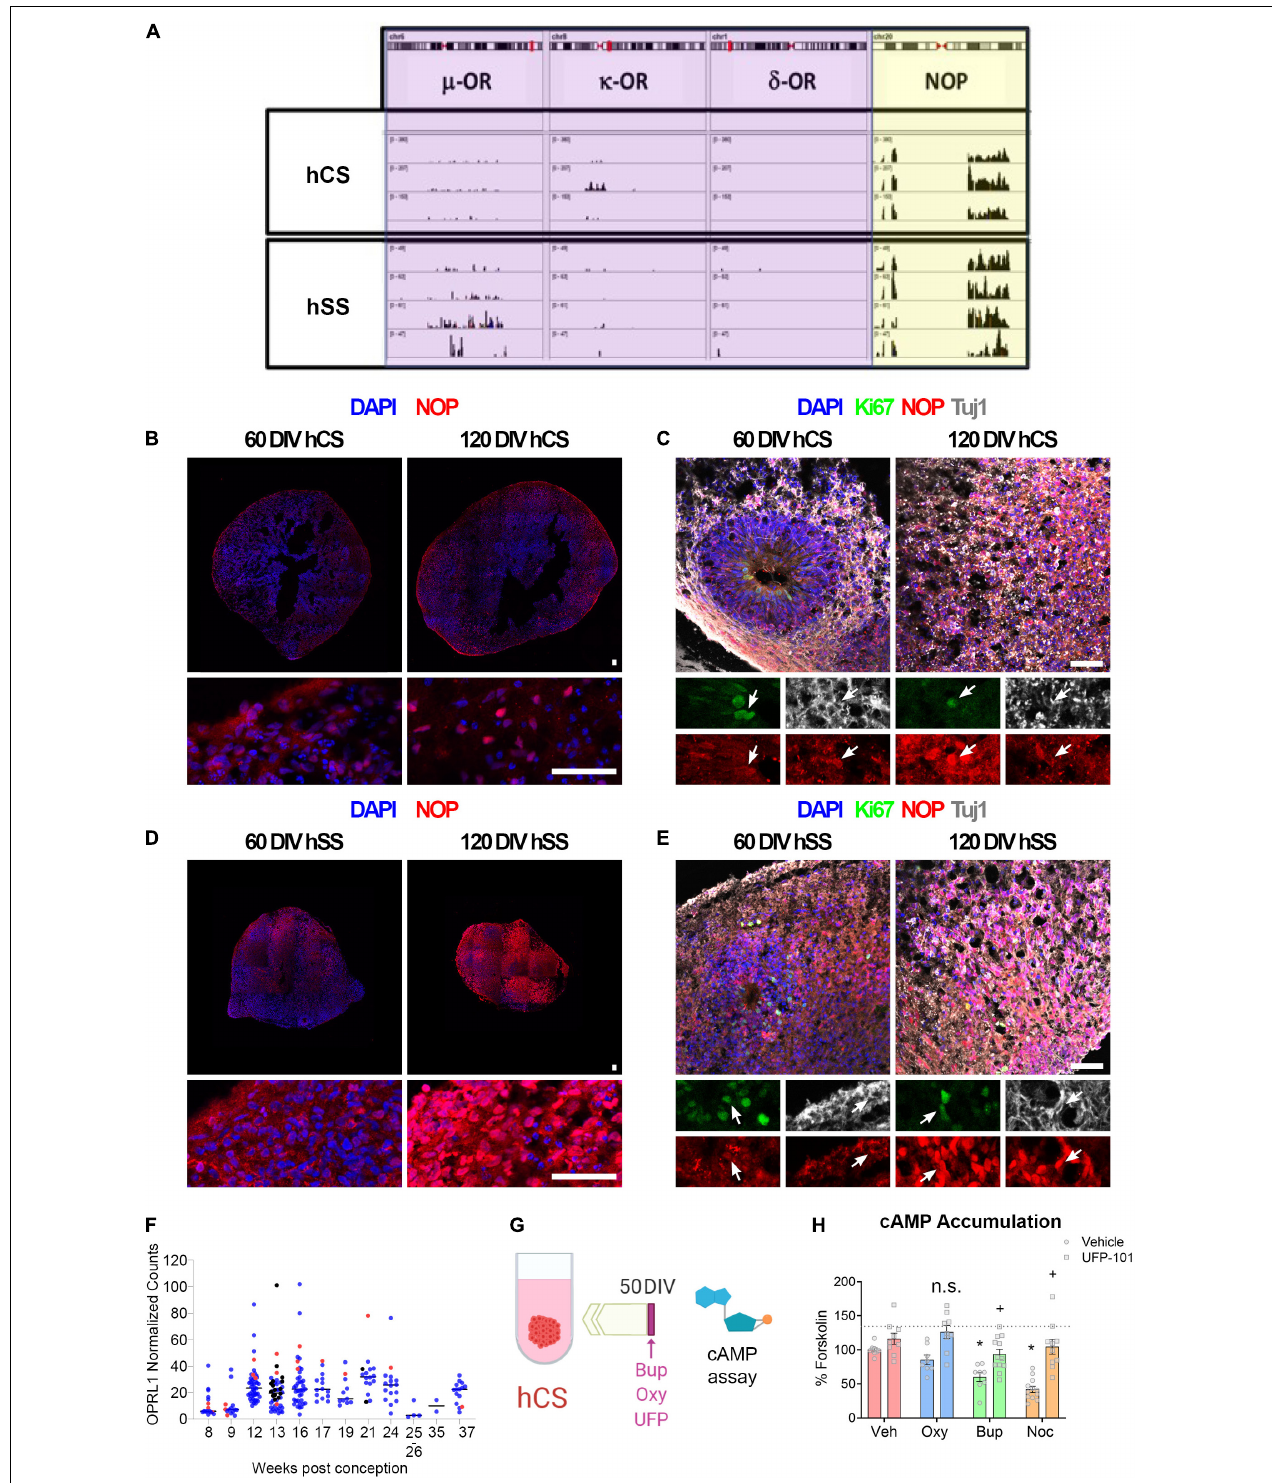
FIGURE 1 | Buprenorphine signals through the nociceptin receptor. (A) RNA Sequencing found that both cortical and subpallial spheroids express the NOP receptor but not the µ -, κ - or δ -opioid receptors. n = 3-4. NOP expression was observed in both cortical (B) and subpallial (D) spheroids. NOP expression co-localized with both Ki67 and Tuj1 (C,E) . (F) Data from fetal brain tissue demonstrating NOP receptor expression in cortical and subpallial regions beginning at 12 weeks. Red dots indicate ganglionic eminences and striatum; blue and black dots indicate cortical tissue from two different samples. n = 1-2. The experimental design for cAMP assays is depicted in (G) . Buprenorphine, like the endogenous NOP receptor ligand, nociceptin, decreases cAMP accumulation. This effect is blocked by treatment with the NOP receptor antagonist, UFP-101 (H) . n = 8-12 organoids. Scale bar = 50 µ m. n.s.,no significant: * and + p < 0.05. DIV,days in vitro .